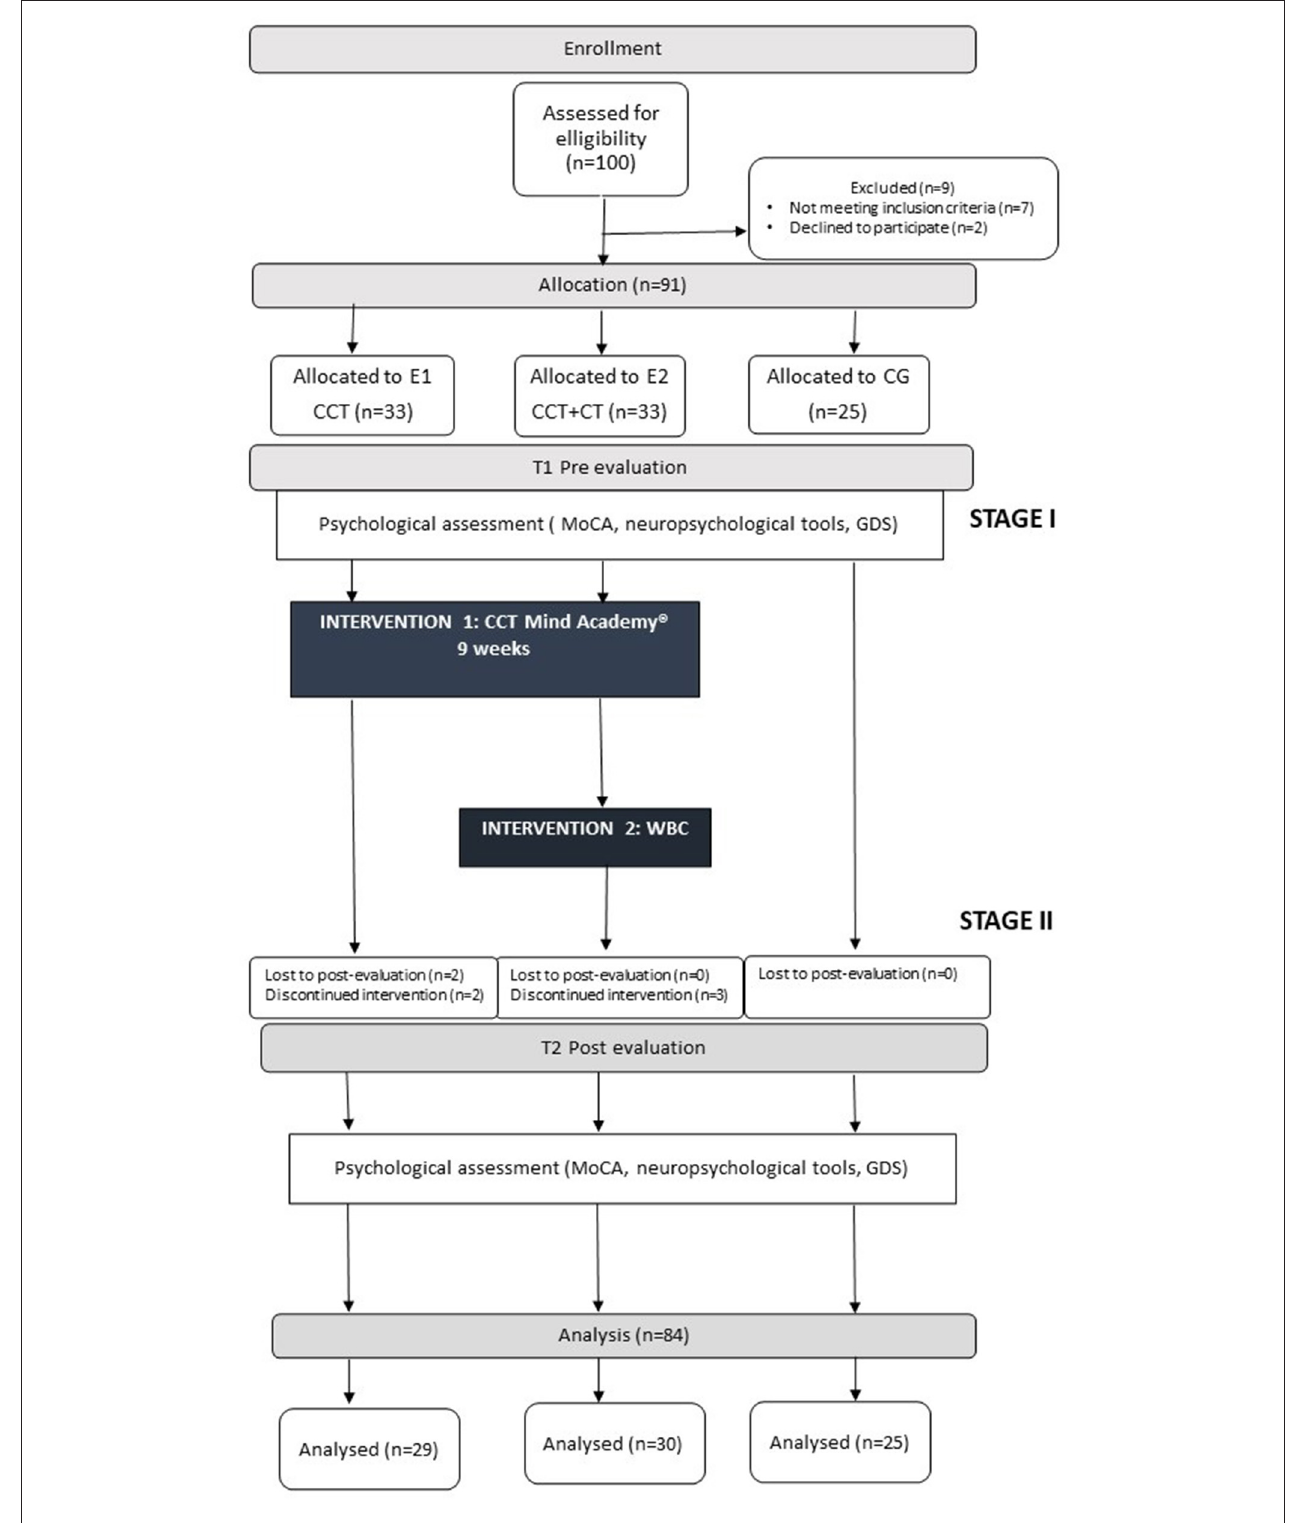
FIGURE 1 | The consort flow diagram modified for non-randomized trial design.